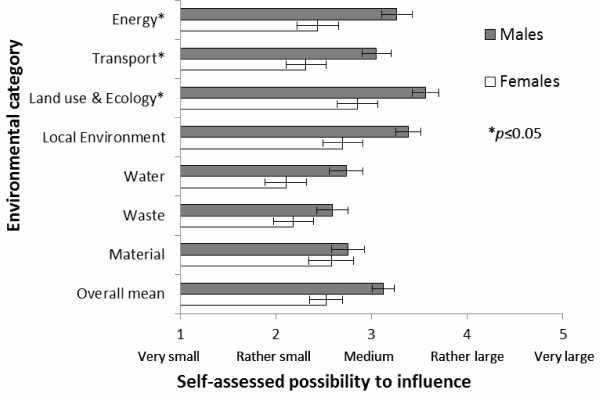
Figure 1. Mean values for self-assessed possibility to influence a range of environmental categories. Error bars represent the standard error of